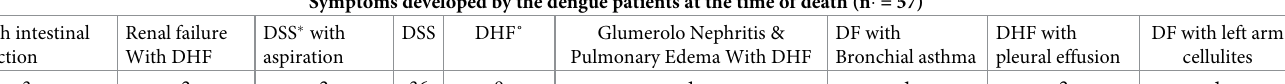
Table 4. The laboratory findings of dengue patients (2013–2015). Symptoms developed by the dengue patients at the time of death (n (cid:1) =